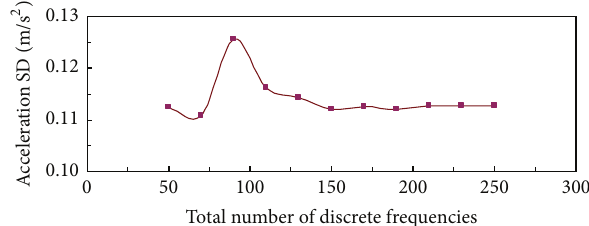
Figure 7: Maximum SD of vertical acceleration of bridge girder midpoint.